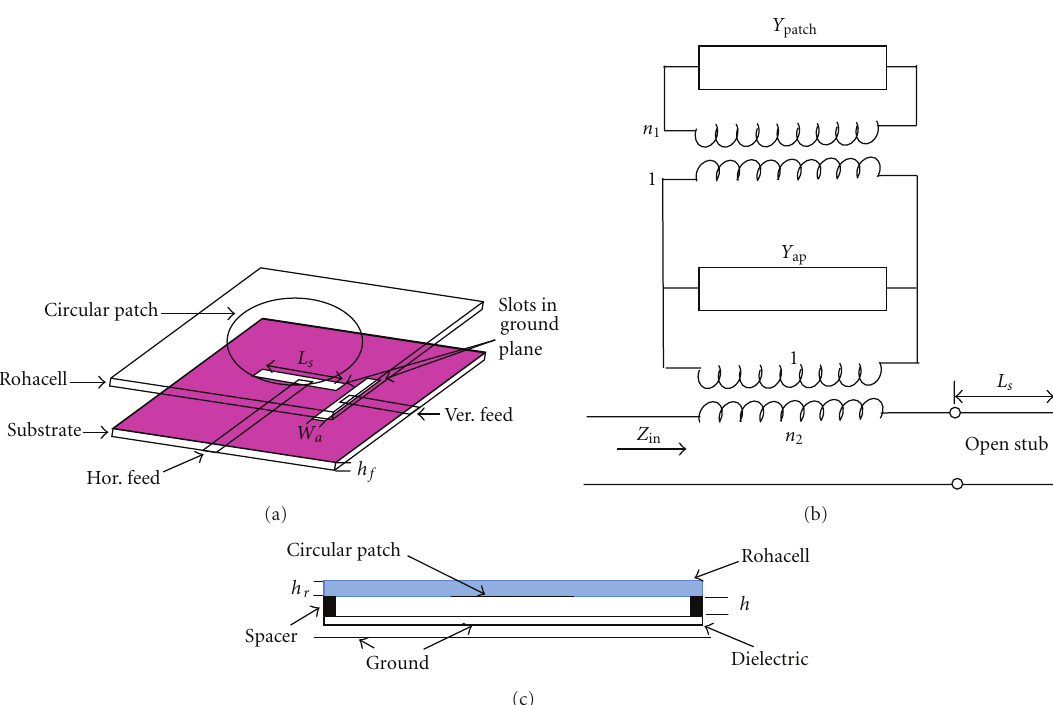
Figure 1: Configuration of the proposed dual-polarized aperture coupled circular patch antenna; (a) 3D view, (b) simplified equivalent circuit model of an aperture coupled microstrip antenna, and (c) 2D view Rohacell: ε r = 1 . 06, h r = 12mm; substrate: ε rf = 4 . 5, h f = 0 . 762 mm, h = 5 . 9 mm; vertical and horizontal apertures’ dimensions or feed slot ( L a × W a ): 14 × 2mm.